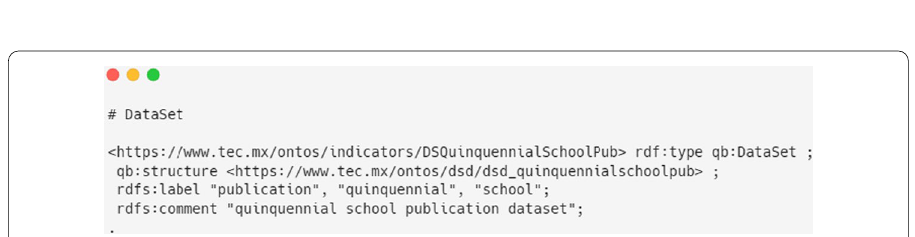
Fig. 3 Example for the school’s publications